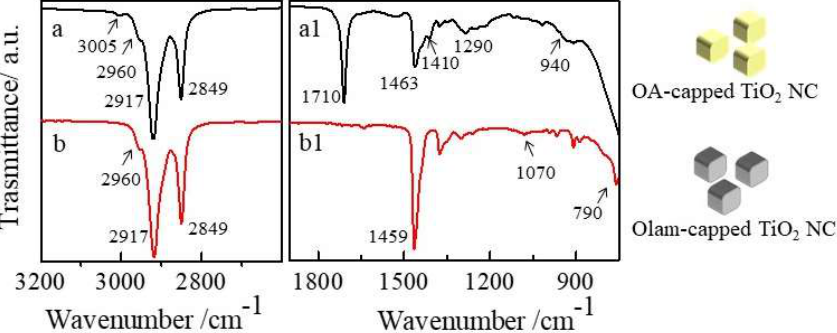
Figure 3. FTIR spectra in the ATR mode of oleic acid (OA)-capped ( a – a1 ) and oleylamine (Olam)-capped TiO 2 NCs ( b – b1 ).